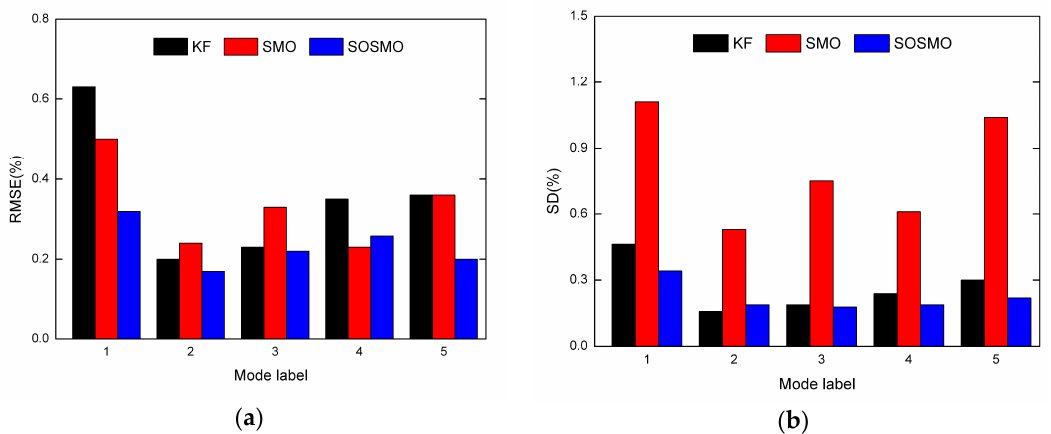
Figure 6. The average RMSE and SD for each fault mode (Mode 1 to 5) in scenarios without uncertainties. ( a ) The average RMSE results; ( b ) The average SD results.